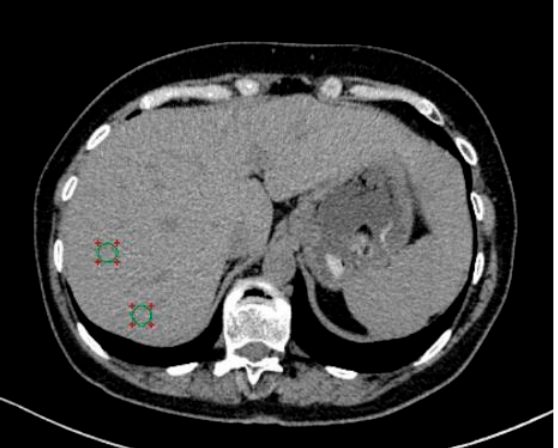
Figure 1. Showing a transverse non-enhanced CT scan with an example of where an ROI should be placed to evaluate attenuation. Two ROIs are positioned in the liver segments VII and VIII, represented by the two green circles.